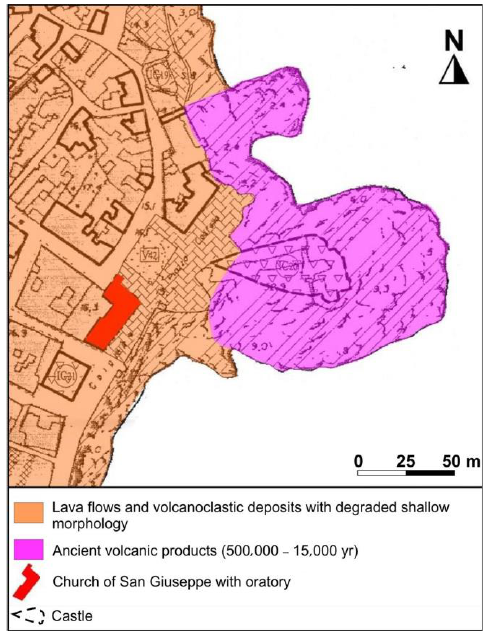
Figure 3. Geological map of the study area (modified from [31]).